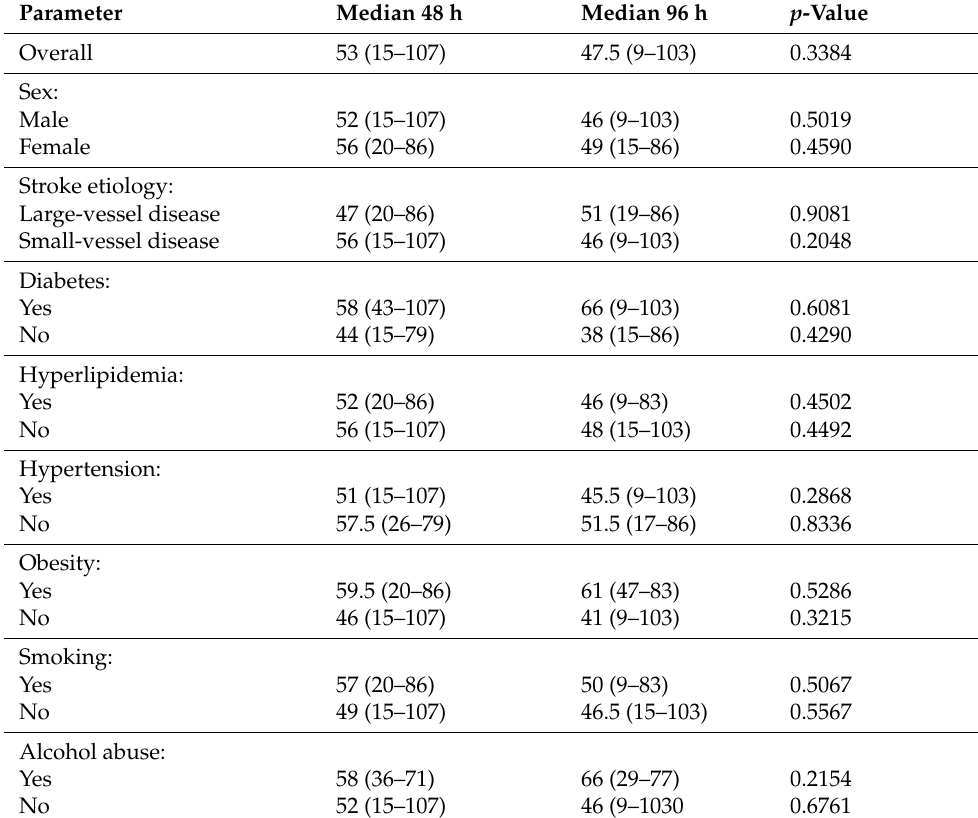
Table 3. The dynamics of platelet reactivity in the group with a single antiplatelet agent